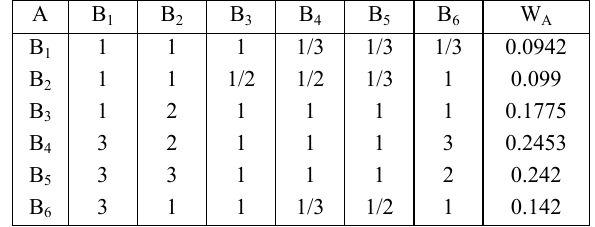
Table 1. The pairwise comparison matrix A–B 1-6